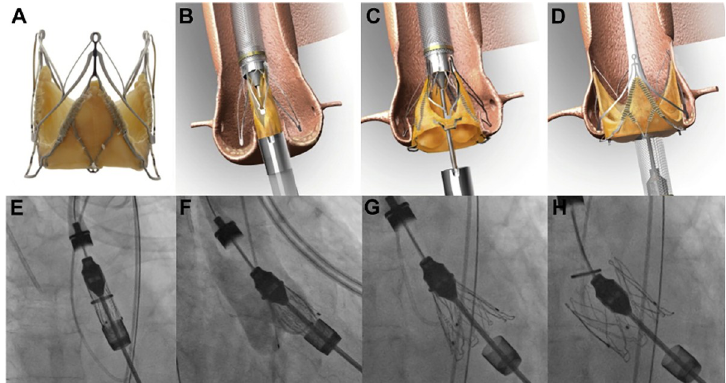
Fig 2. “The JenaValve transcatheter heart valve (THV) prosthesis (JenaValve Technology GmbH, Munich, Germany), a trileaflet porcine root tissue valve attached to a nitinol stent (A) and its implantation in illustration (B to D) and fluoroscopy (E to H). Release of the positioning feelers and placement into the aortic sinuses enables anatomic orientation (B and F). After correct orientation has been verified in 2 different fluoroscopic angulations, release of the lower stent part facilitates the clipping of the native aortic valve leaflets to the device and expansion of the stent allowing for secure anchoring even in the absence of valve calcium (C and G). Release of the upper stent part completes deployment of the valve prosthesis (D and H)”